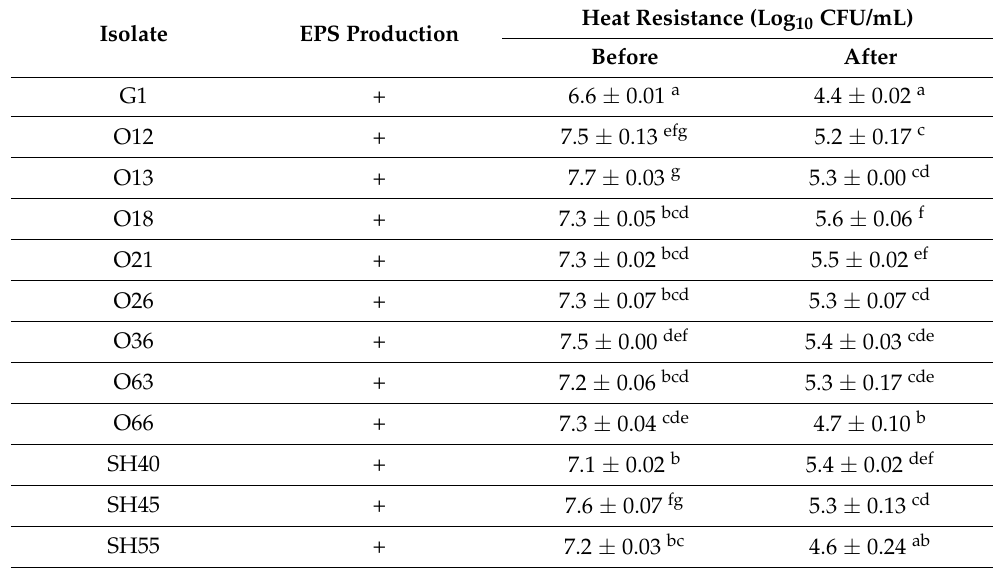
Table 6. Exopolysaccharide (EPS) production and heat resistance (Log 10 CFU/mL) of 12 potential probiotic yeast